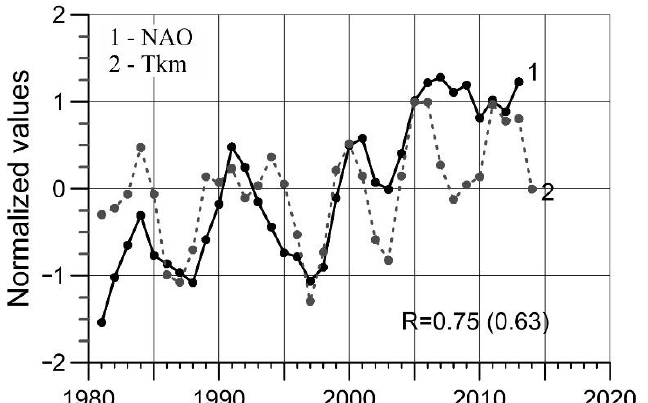
Figure 5. Normalized average annual values of the NAO (1) and water temperature in 50 – 200 m layer at section along the Kola meridian in the Barents Sea (2). R is the correlation coefficient between (1) and (2), in parentheses is the correlation coefficient between no smoothed series. The timeline corresponds to temperature changes, changes in NAO are shifted by 3 years ahead.